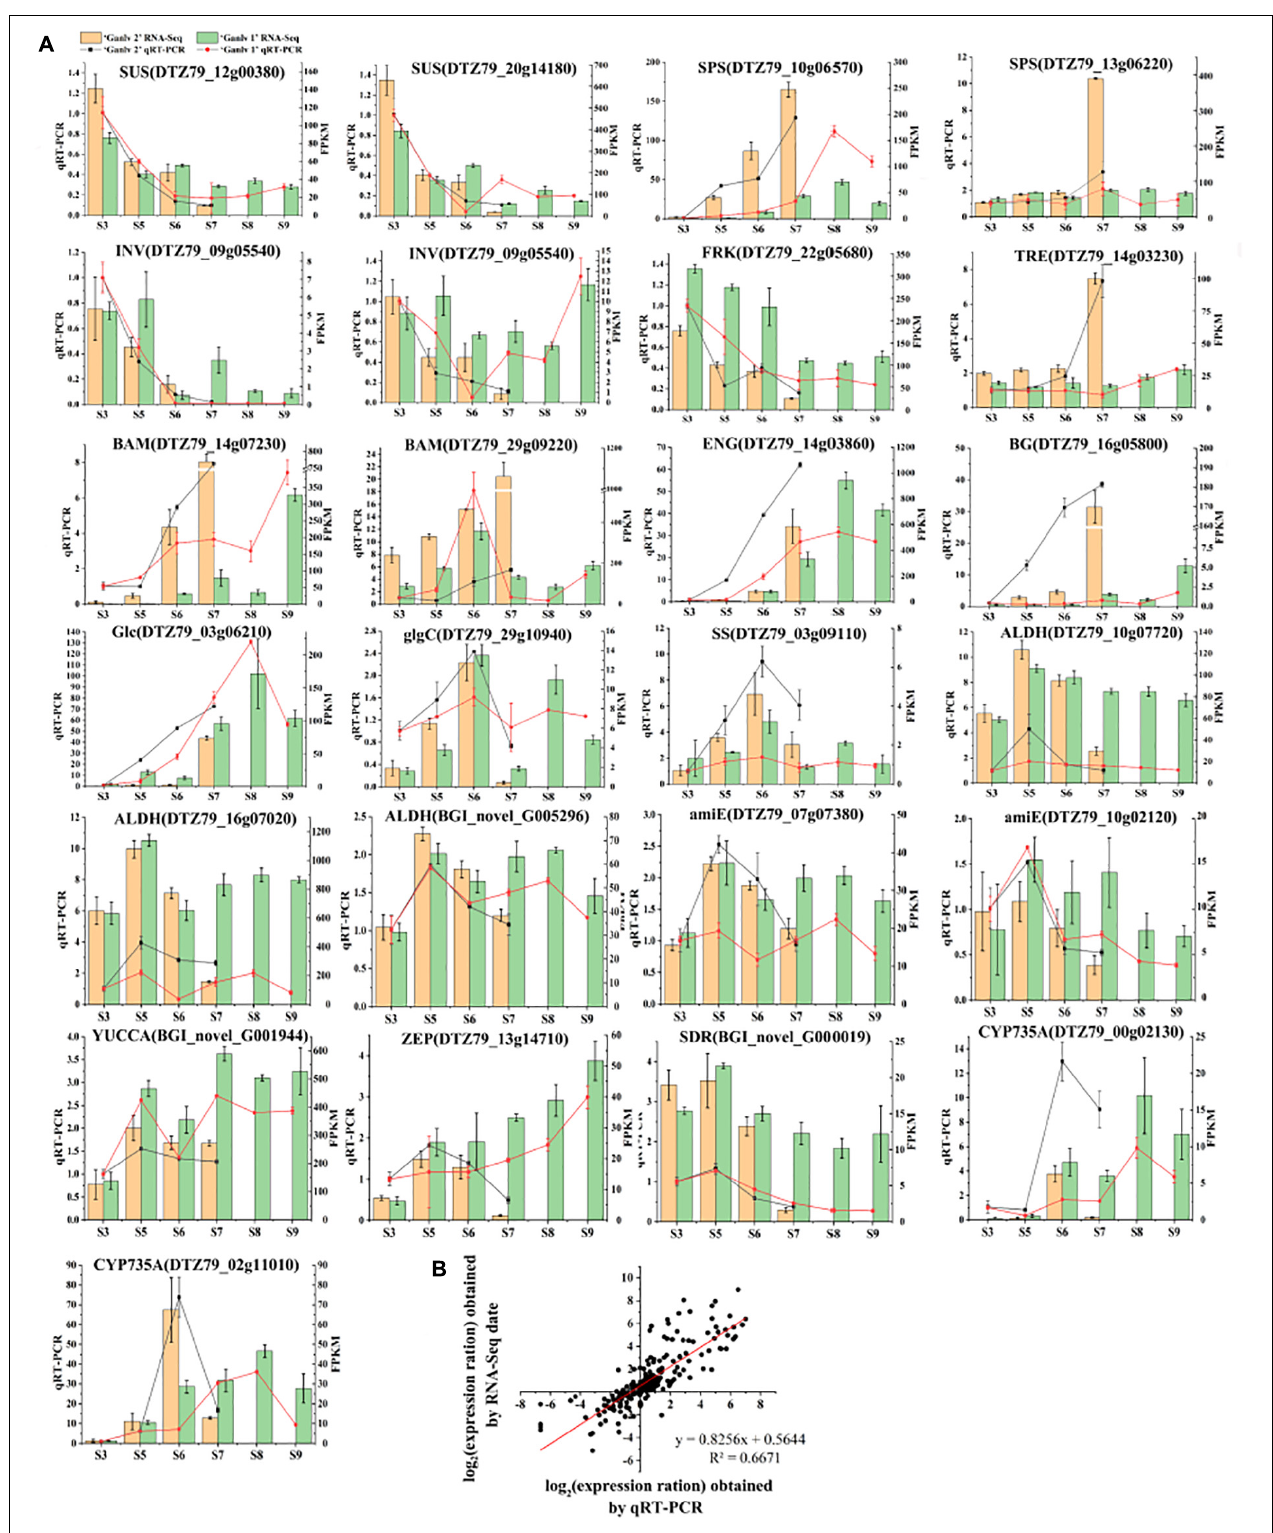
FIGURE 8 | Analysis of gene expression of key candidate genes. Expression level by qRT-PCR and RNA-Seq (A) , the bar chart is RNA-seq data, yellow and green represent ‘Ganlv 2’ and ‘Ganlv 1’, respectively; the line chart was qRT-PCR data, black and red represent ‘Ganlv 2’ and ‘Ganlv 1’, respectively. Correlation analysis of RT-qPCR data and RNA-seq data (B)